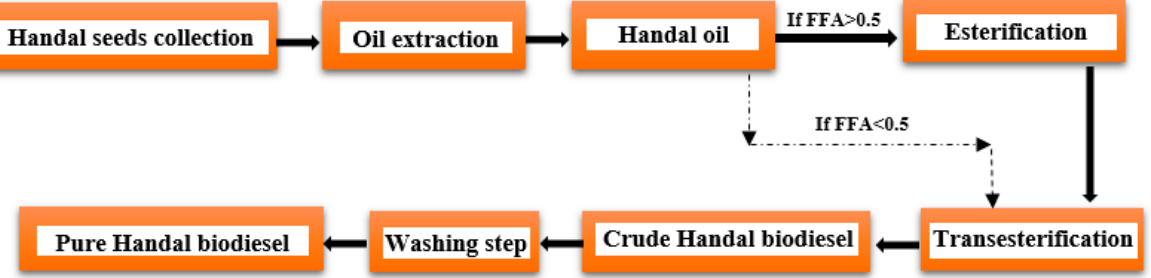
Figure 11. Process flow diagram for the synthesis of biodiesel from Handal seed oil.